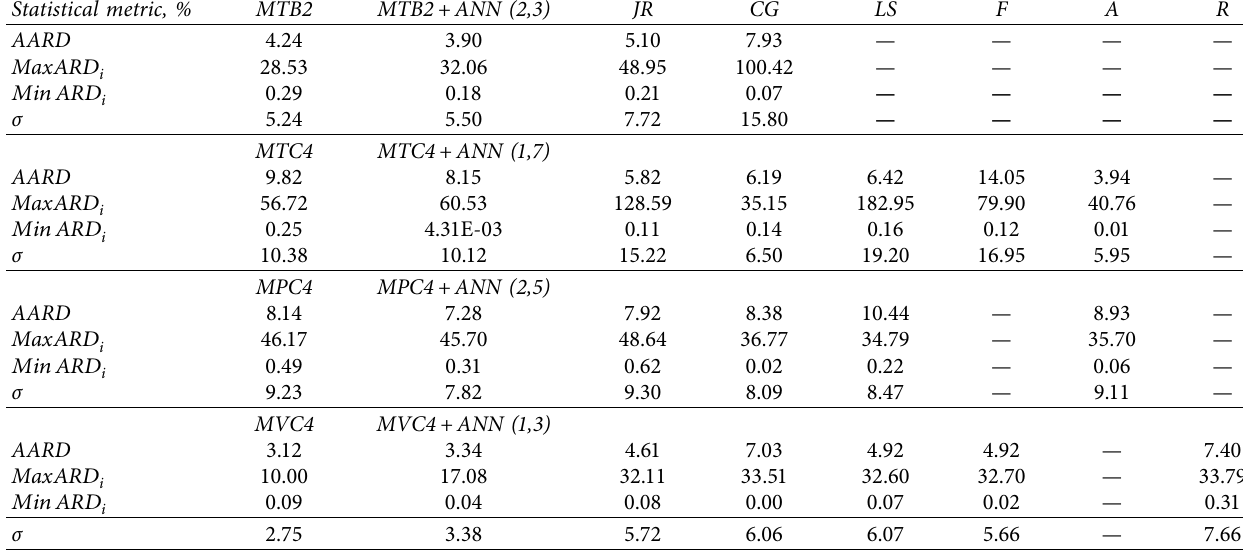
Table 4: Comparison of the performance of different GCMs in the calculation of critical properties and normal boiling point of pure